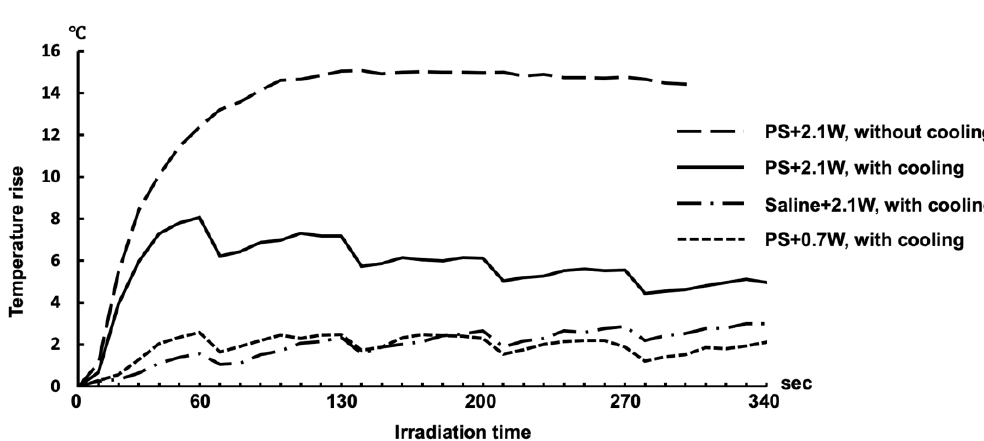
Figure 5. Temperature transitions on the root surface of extracted human teeth during laser irradiation. In the group without air-cooling, the laser was applied continuously for 5 min. In the air-cooled groups, the laser operated intermittently for 5 min with a 10 s rest period every minute. The average of the highest temperatures within a heat distribution captured by thermography is indicated in the polygonal line graph ( n = 5).